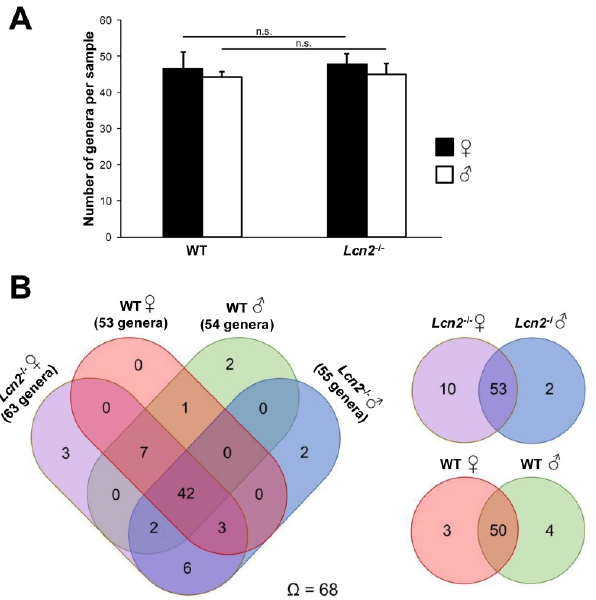
Figure 4. Gender-specific diversity and genus spectrum of the intestinal microbiome of Lcn2 -/- and wild type mice. ( A ) The bars represent the arithmetic mean of the genera per sample ( ± SD; Lcn2 -/- (n = 7 or 5) and wild type mice (n = 7 or 3)). Statistical evaluation was performed using the Kruskal–Wallis test, whereby the difference of two samples from a level of p < 0.05 is considered statistically significant (n.s. = not significant). ( B ) Venn diagram showing shared genera between the different groups by absolute numbers ( Ω = total number of genera).